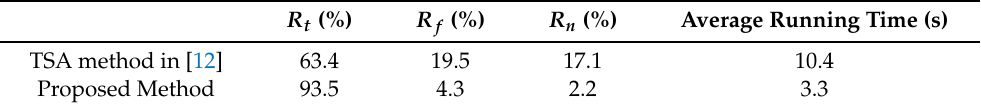
Table 4. Performance comparisons between two tracklet association